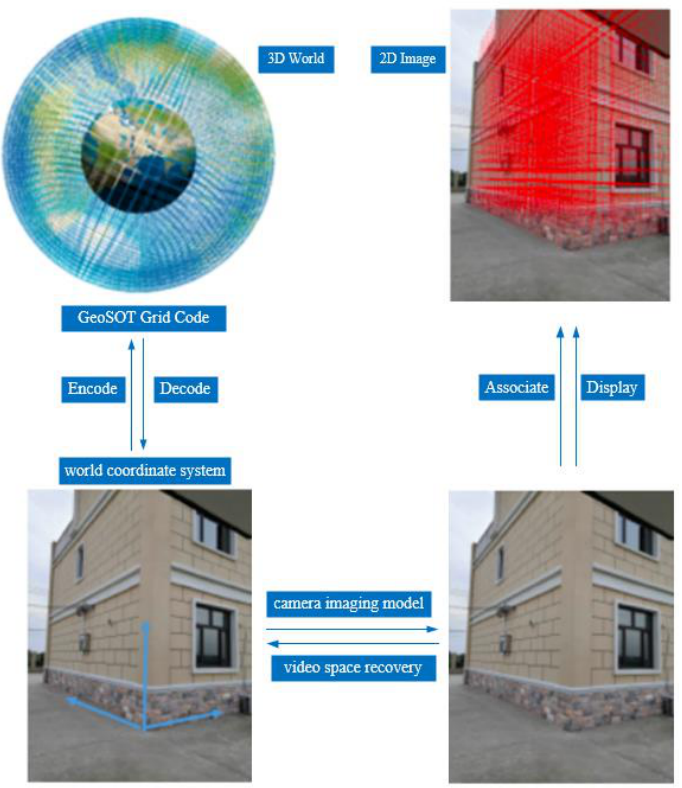
Figure 1. Mapping relationships between different coordinate systems in the model.